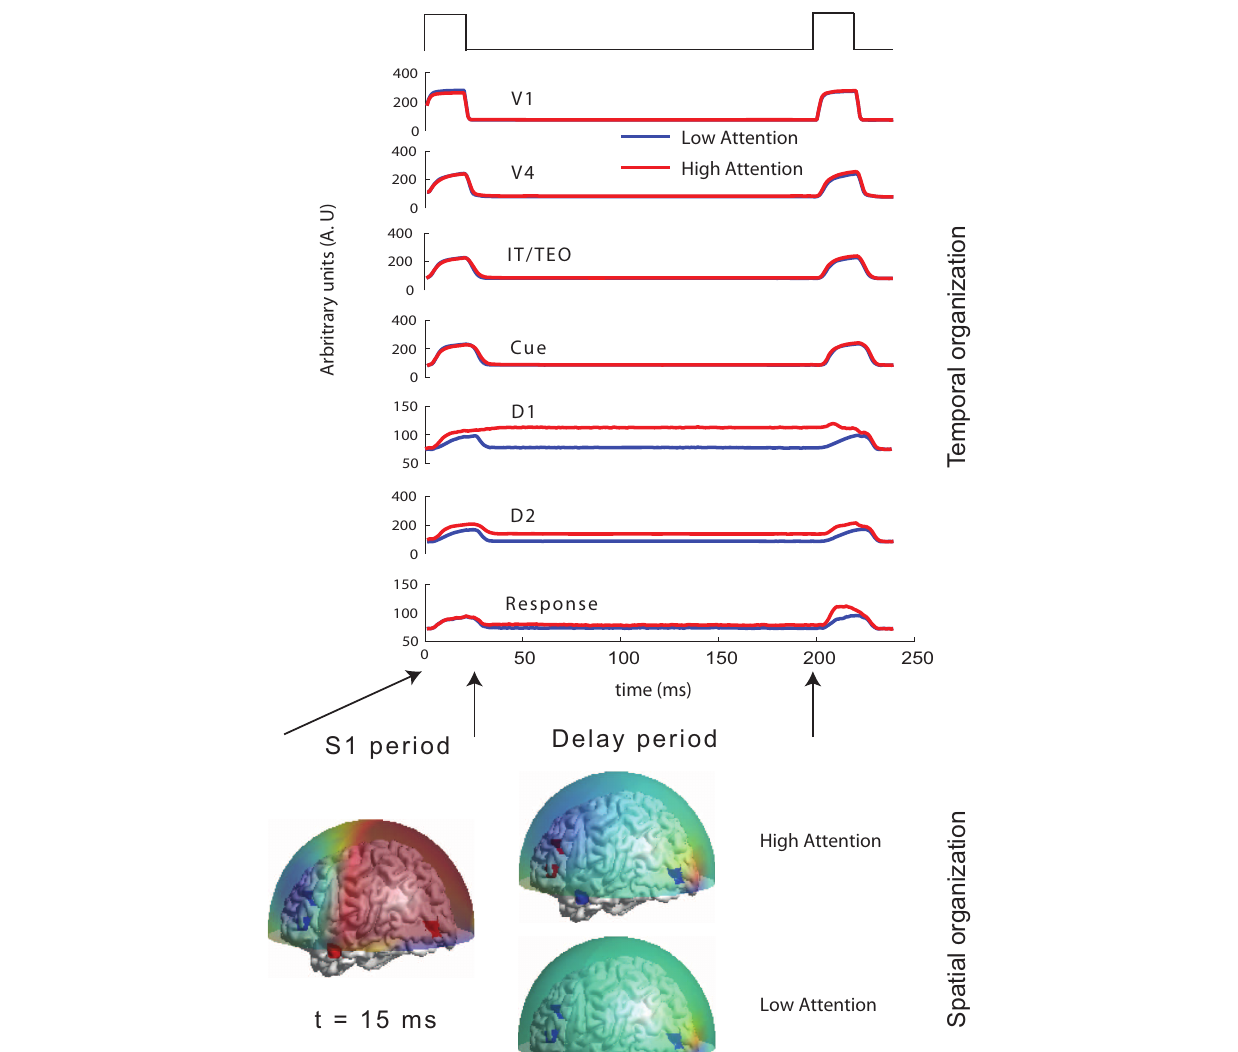
FIGURE 2 | Temporal and spatial organization of simulated neural activity: Total currents in each brain location computed using the large-scale neural model for two different levels of attention (0 and 0.3). During stimulus S1, the sensory and object identification areas are first activated (V1, V4 and IT) followed by activations in prefrontal network (D1, D2, C, and R). For low attention (or zero attention) all units are silent during delay period because no working memory is required to perform the DMS task. D1 and D2 units have sustained activation (recruited) during delay period if high attention is required to store the identity of S1 in working memory while the other units were silent. Neuromagnetic (MEG) activity is simulated at 264